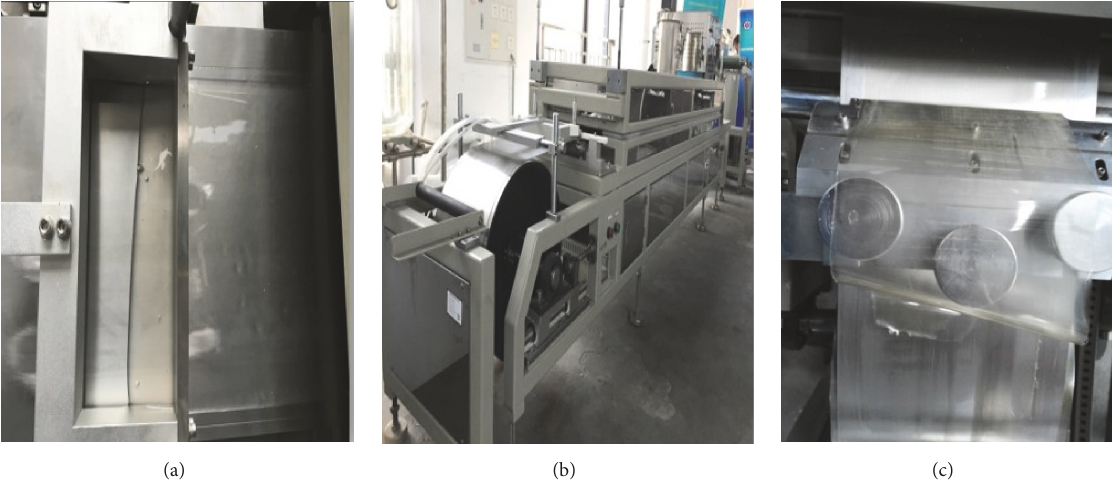
Figure 1: Casting machine used for films produced: (a) film-forming solution, (b) film drying, and (c) finished